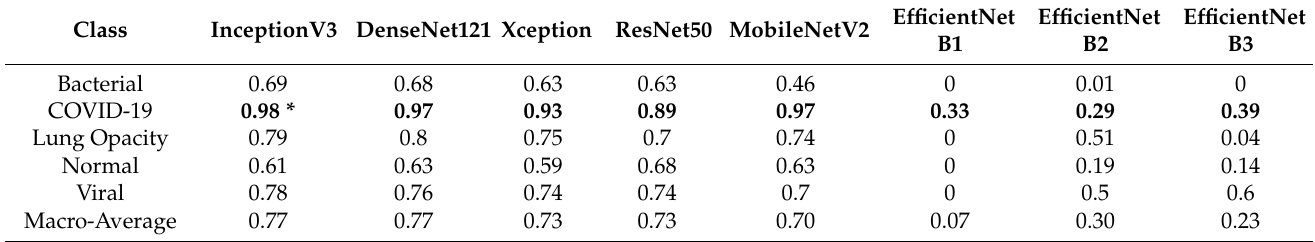
Table 8. Class-wise F1-score for supervised CNN models with entire labeled dataset.